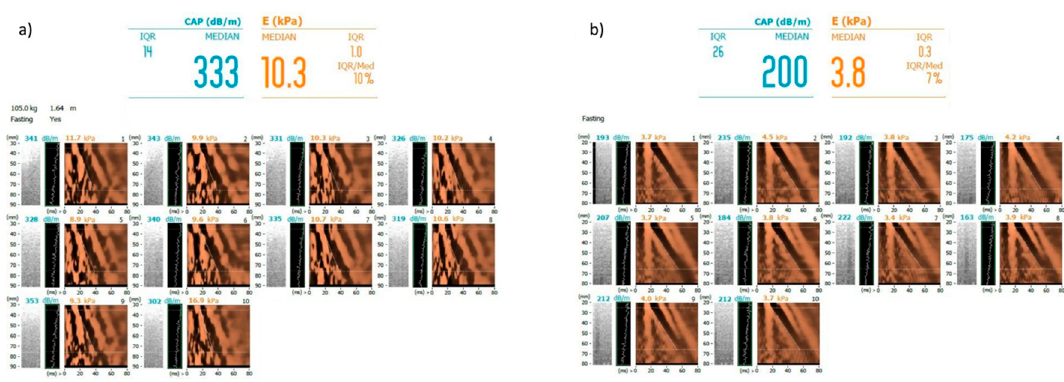
Figure 6. Examples of steatosis assessment by controlled attenuation parameter and liver stiffness assessment by transient elastography (Fibroscan) ( a ) in a patient with severe liver steatosis (grade 3) and severe fibrosis (F3) ( b ) in a patient with no liver steatosis (grade 0) and no liver fibrosis (F0). Images courtesy of Dr. Maciej Janik and Prof. Piotr Milkiewicz from the Liver and Internal Medicine Unit, Medical University of Warsaw.